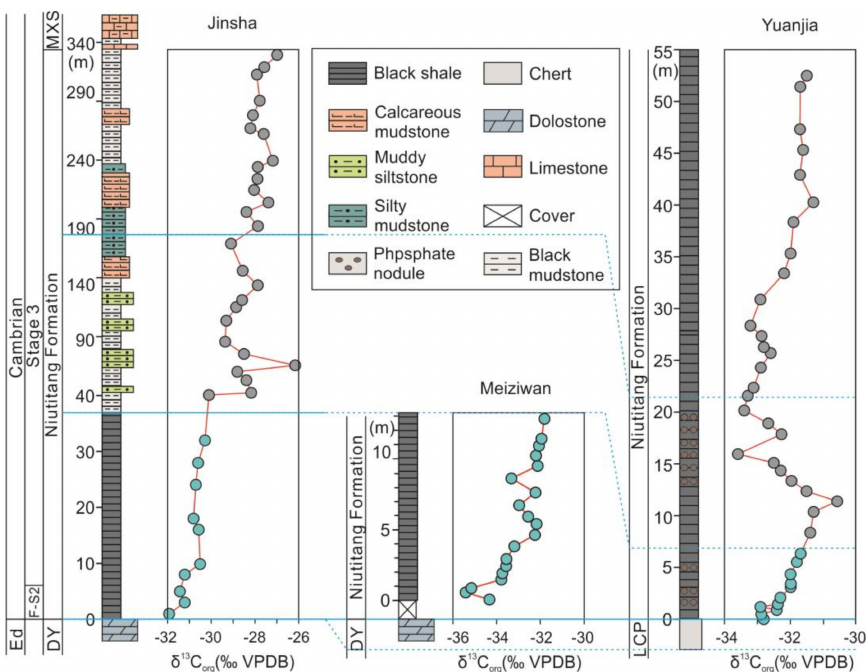
Figure 2. Stratigraphic correlation of the Meiziwan with Jinsha and Yuanjia sections based on the variations of δ 13 C org . Data sources: Meiziwan (this study); Jinsha [41]; Yuanjia [49]. Abbreviations: Ed = Ediacaran; F = Fortunian; S2 = Stage 2; DY = Dengying Formation; LCP = Liuchapo Formation; MXS = Mingxinsi Formation. Dashed line refers to uncertainty over the precise correlation position.